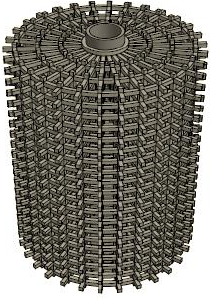
Figure 1. Heat exchanger tube with wire.